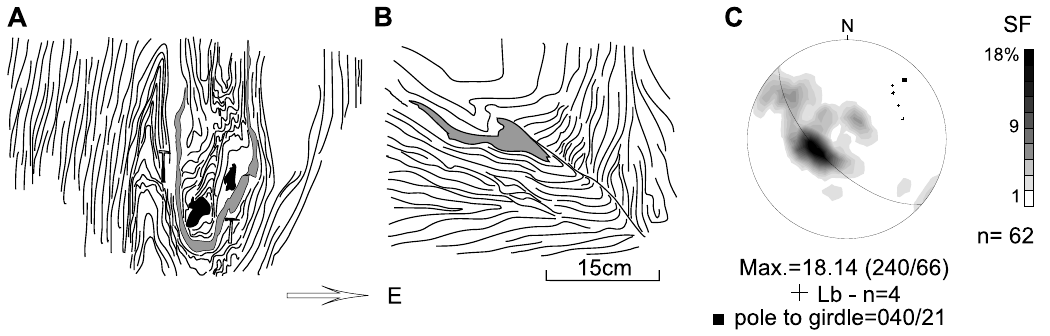
Fig. 7 – Pattern of folding near the road junction at Bom Jesus do Itabapoana, RJ. A – Meter-scale isoclinal fold with strongly thickened fold hinge in an antiform affecting a grey lenticular granite mass. This structure is affected by the presence of dark calc-silicate enclaves; B – Tight fold with thickened fold hinge associated with a grey granitic vein; C – Stereographic projection of the poles to the folded foliation (SF), fold axes (Lb) with pole adjusted to the girdle. The number of data points (n) and the direction of the section are